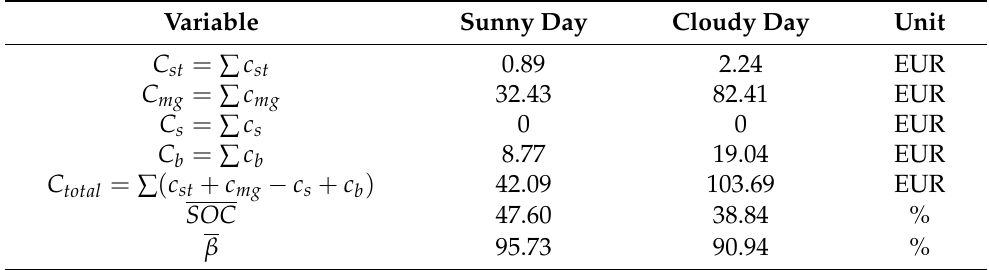
Table 2. Aggregated output values associated with microgrid operation cost and averaged state of charge and energy demand reduction coefficient values for sunny and cloudy